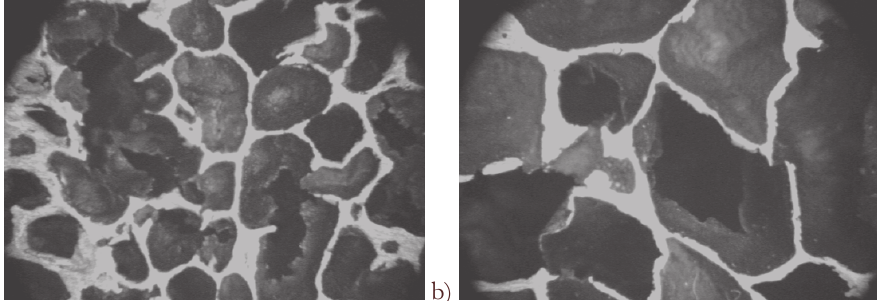
Figure 6: Macro cracks inside the cell walls in (a) AlSi11Mg0.6 foam and (b) AlMg1Si0.6 foam as a result of foaming process (0.2 volume fraction of